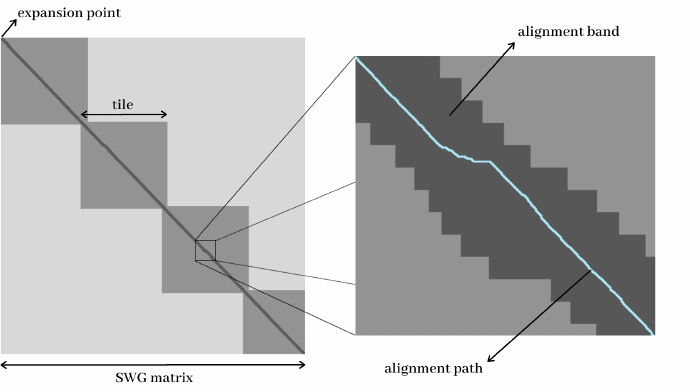
Figure 4. Example of a GACT-X SWG semi-global alignment with expansion from the top-left corner. For reference, the scale is based on the values of query and target lengths of 14,000 bases, tile size being 4000, the tile overlap being 128, and 32 rows in each stripe. The SWG matrix is the widest light square on the left; the alignment was finished with 4 tiles in medium gray. The X-drop band of calculated cells is in dark gray, which can be seen more clearly on the zoom-in on the right, with the final alignment path in light blue.